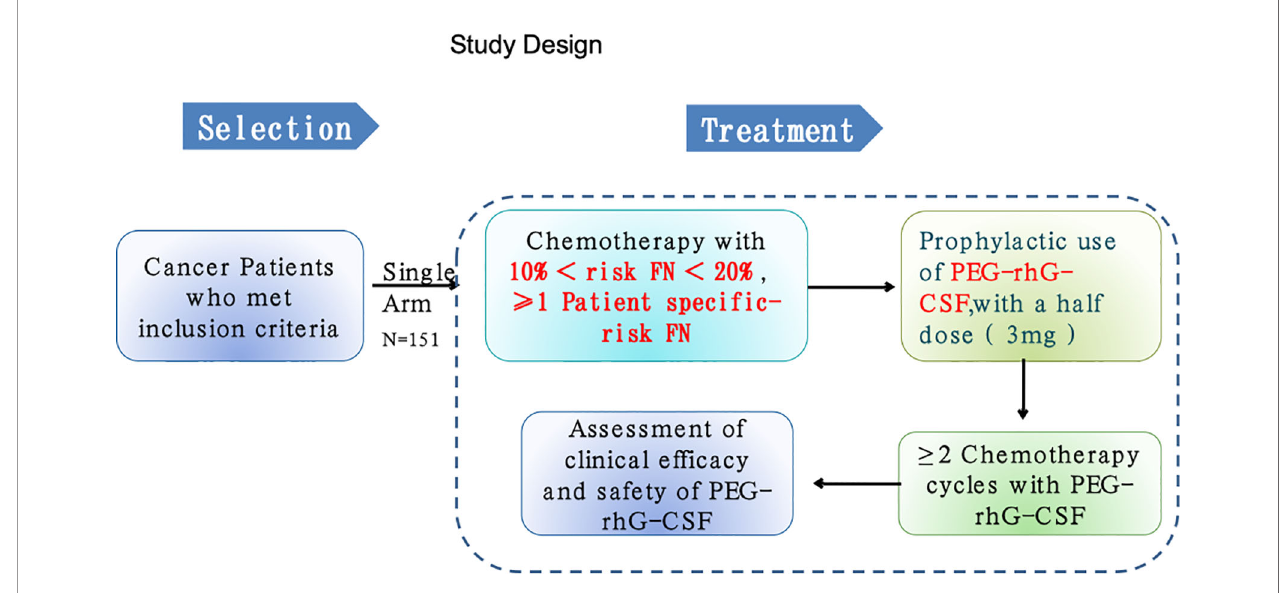
FIGURE 1 | The chart of study